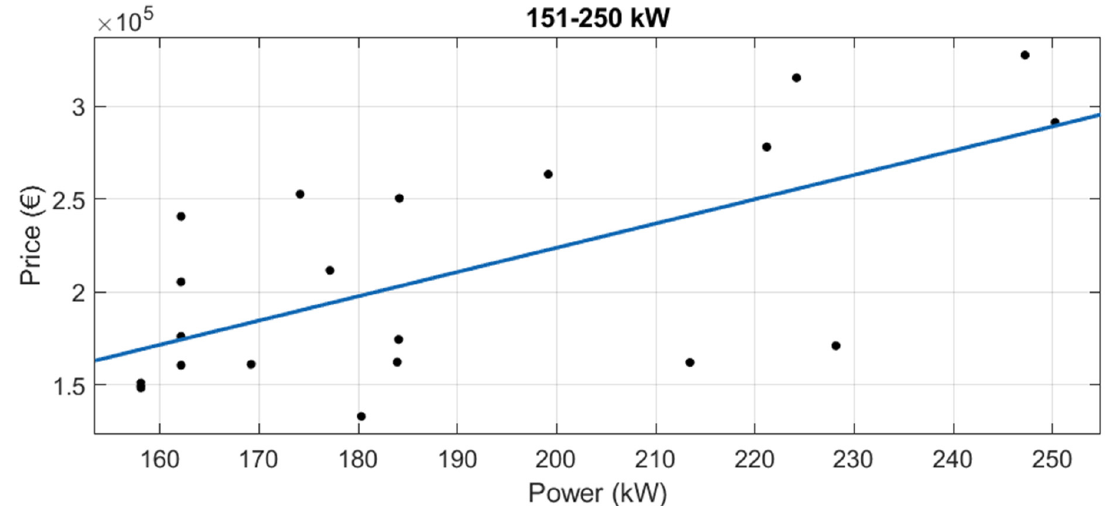
Figure 14. Price vs. power for new tractors from 151 to 250